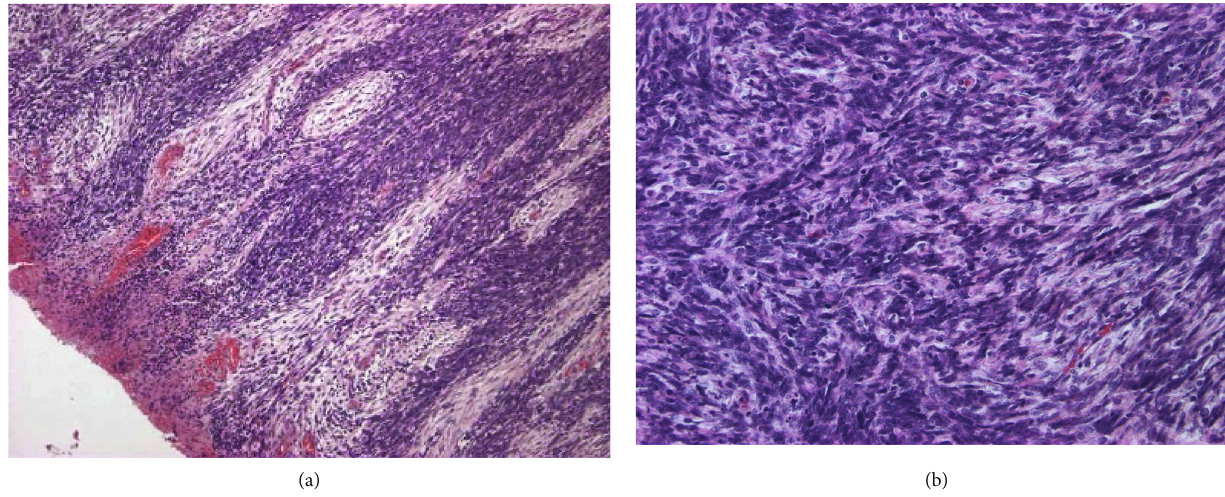
Figure 2: Histological characteristics of the vulval tumor. (a) Abnormal proliferation of spindle and ovoid cells (hematein-eosin × 100). (b) Tumoral proliferation of basophilic cytoplasm cells, with elongated or oval nuclei and anisocaryosis (hematein-eosin × 400).